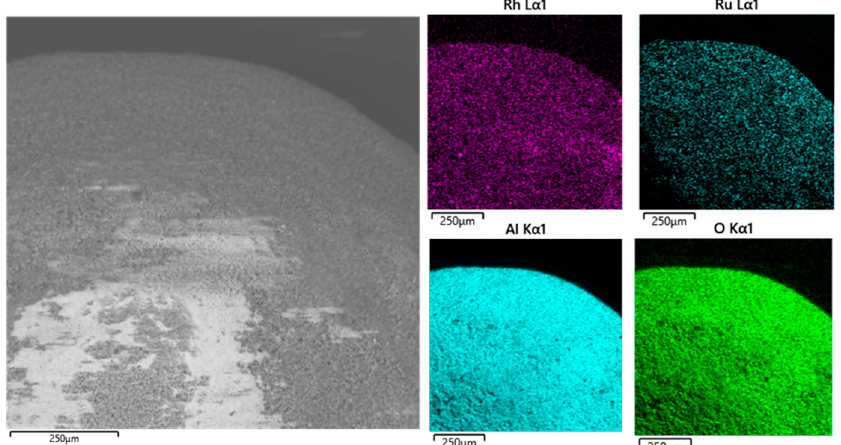
Figure 4 . SEM-EDX Rh- γ Al 2 O 3 .